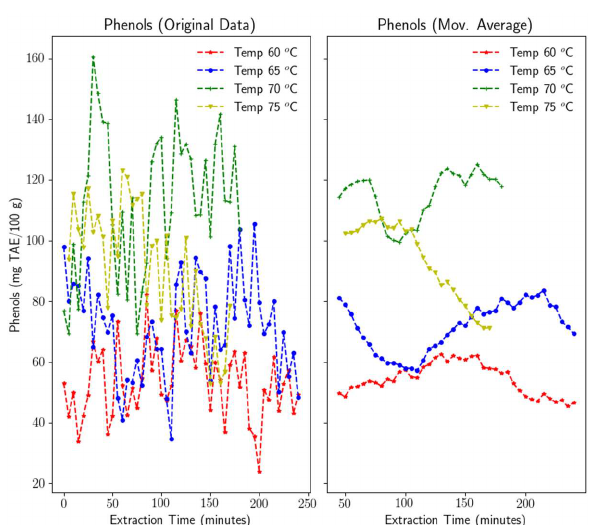
Figure 4. Phenol content with different extraction times and at different temperatures.